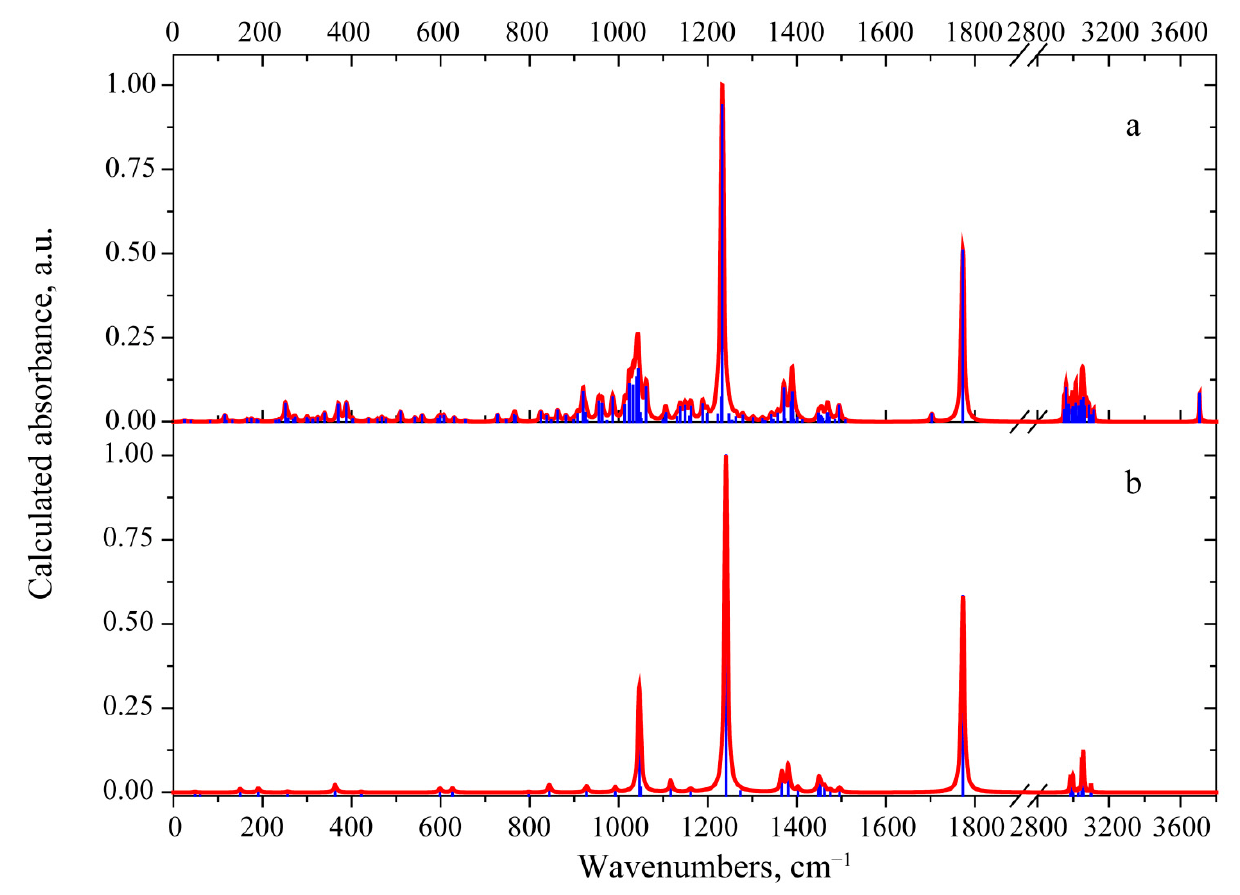
Figure 4. The calculated scaled IR absorbance spectrum of 3-deacetylcalonectrin ( a ) and ethyl acetate model ( b ). Table 1. Selected experimental peaks and calculated modes for 3-deacetylcalonectrin. In the table, the following notations have been used: v—stretching vibrations, δ —bending vibrations, asym— asymmetric, sym—symmetric vibrations, w—wagging, tors—torsional, τ —twisting, ρ —rocking modes. In the case of water-like >CH 2 structures, v sym and v asym correspond, respectively, to symmetric and asymmetric water-like stretching vibrations, with corresponding atoms in parentheses. The upper index denotes the atom number and lower index denotes the number of elements attached to the previous